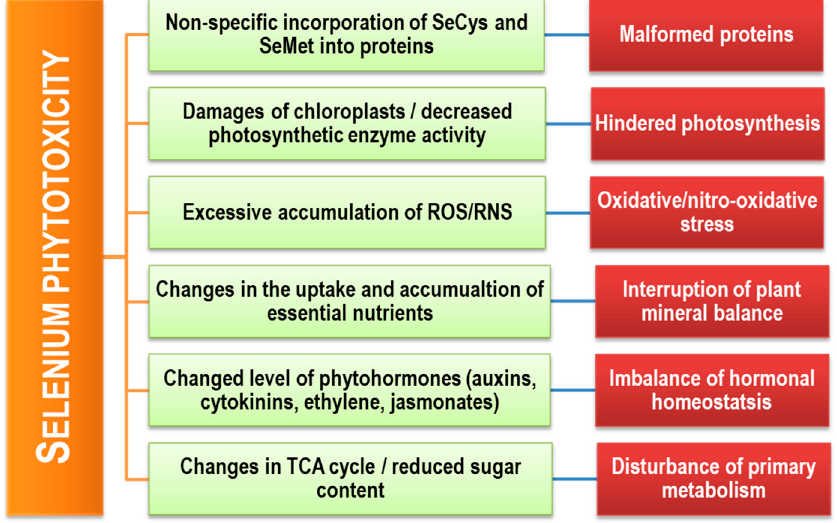
Figure 4. A schematic representation of the causes and consequences of Se toxicity in plants.